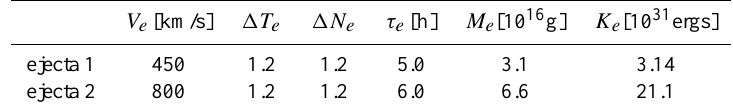
Table 2. One-dimensional simulation. Characteristics of the ejecta-like pulses: Initial velocity ( U e ), increment of density ( 1N e = N e /N o ) and temperature ( 1T e = T e /T o ) with respect to the ambient wind at ro, temporal duration ( τ e ), total mass ( M e = P n